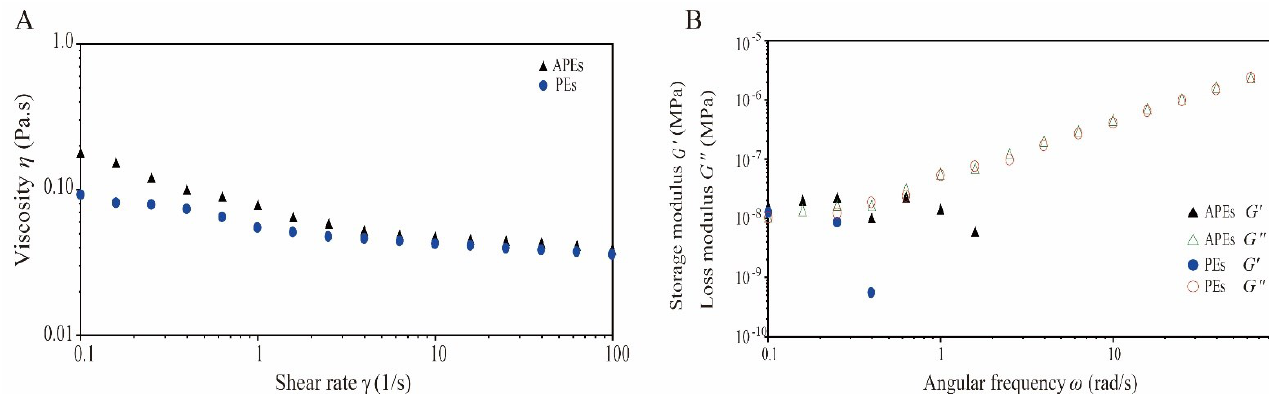
Figure 3. Rheological properties of APEs as compared with PEs at 25 ◦ C. ( A ) Viscosity ( η ) as a function of shear rate ( γ ) increased from 0.1 to 100 s − 1 , ( B ) dynamical oscillatory frequency sweep test curves of storage modulus ( G ′ ) and loss modulus ( G ′′ ) vs. angular frequency ( ω ) from 0.1 to 100 rad/s.